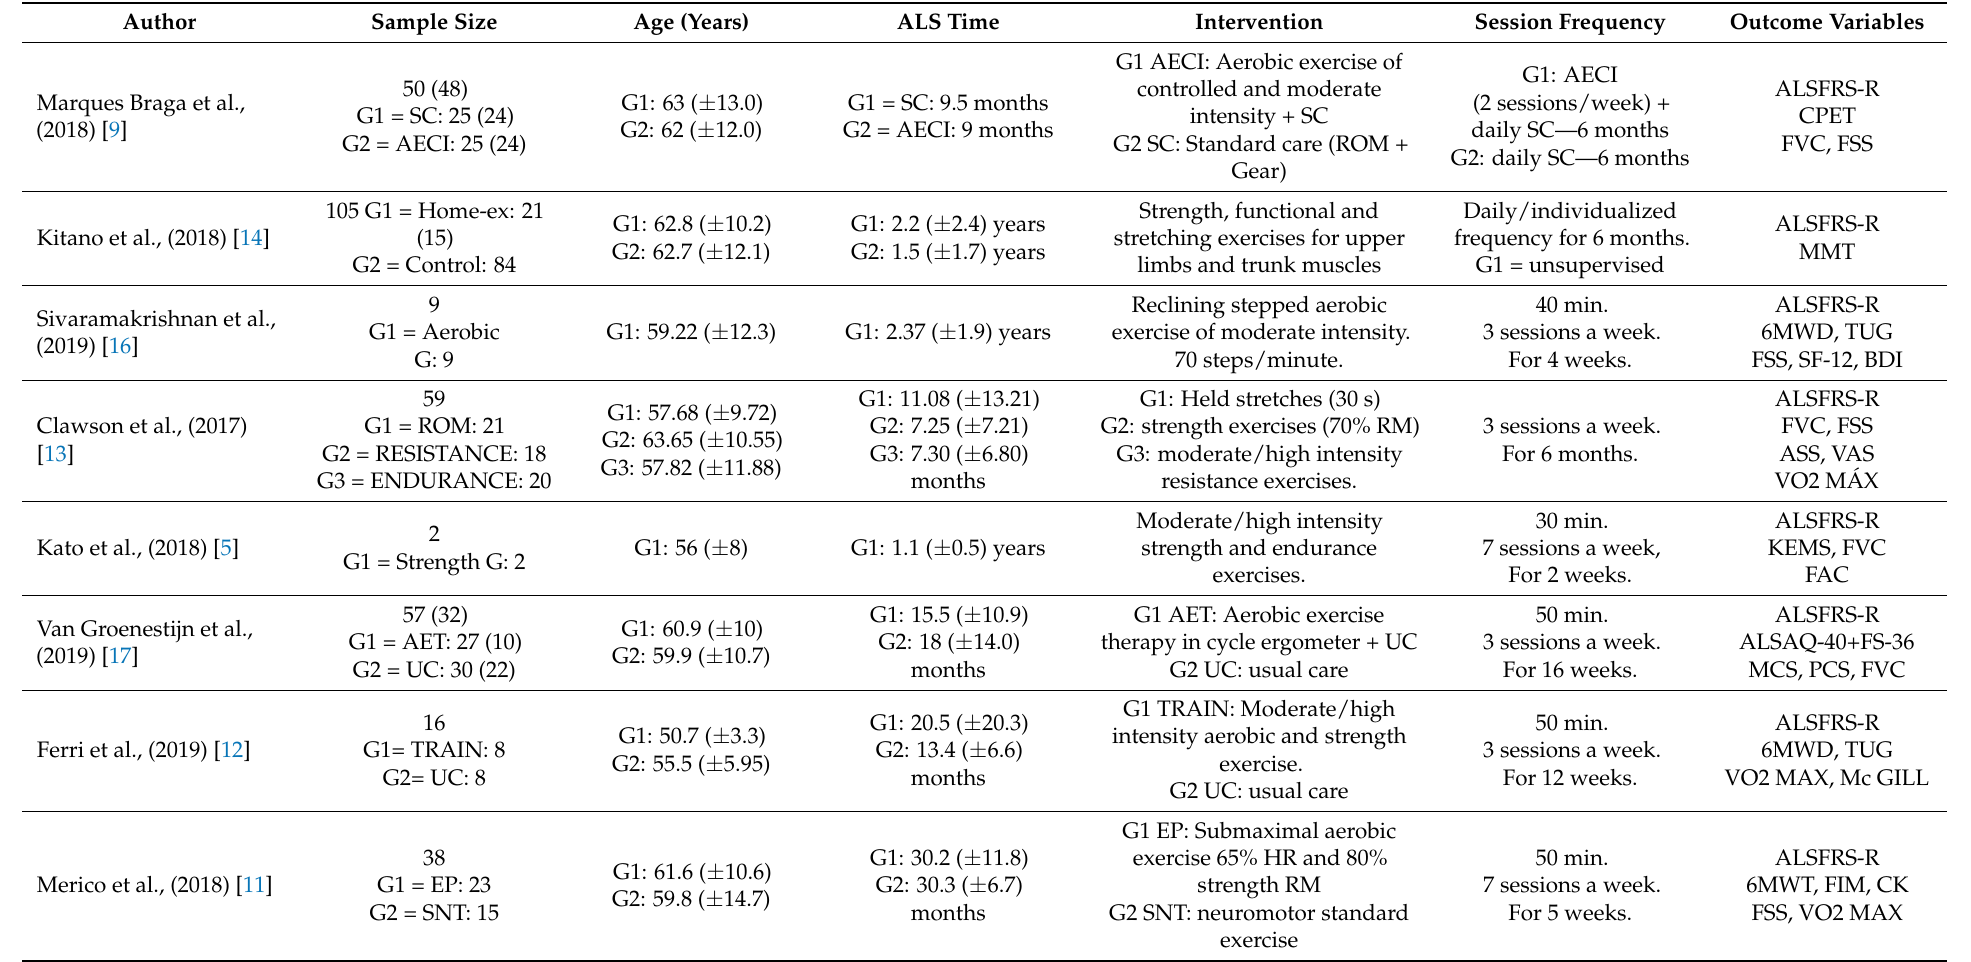
Table 2. Characteristics of the included